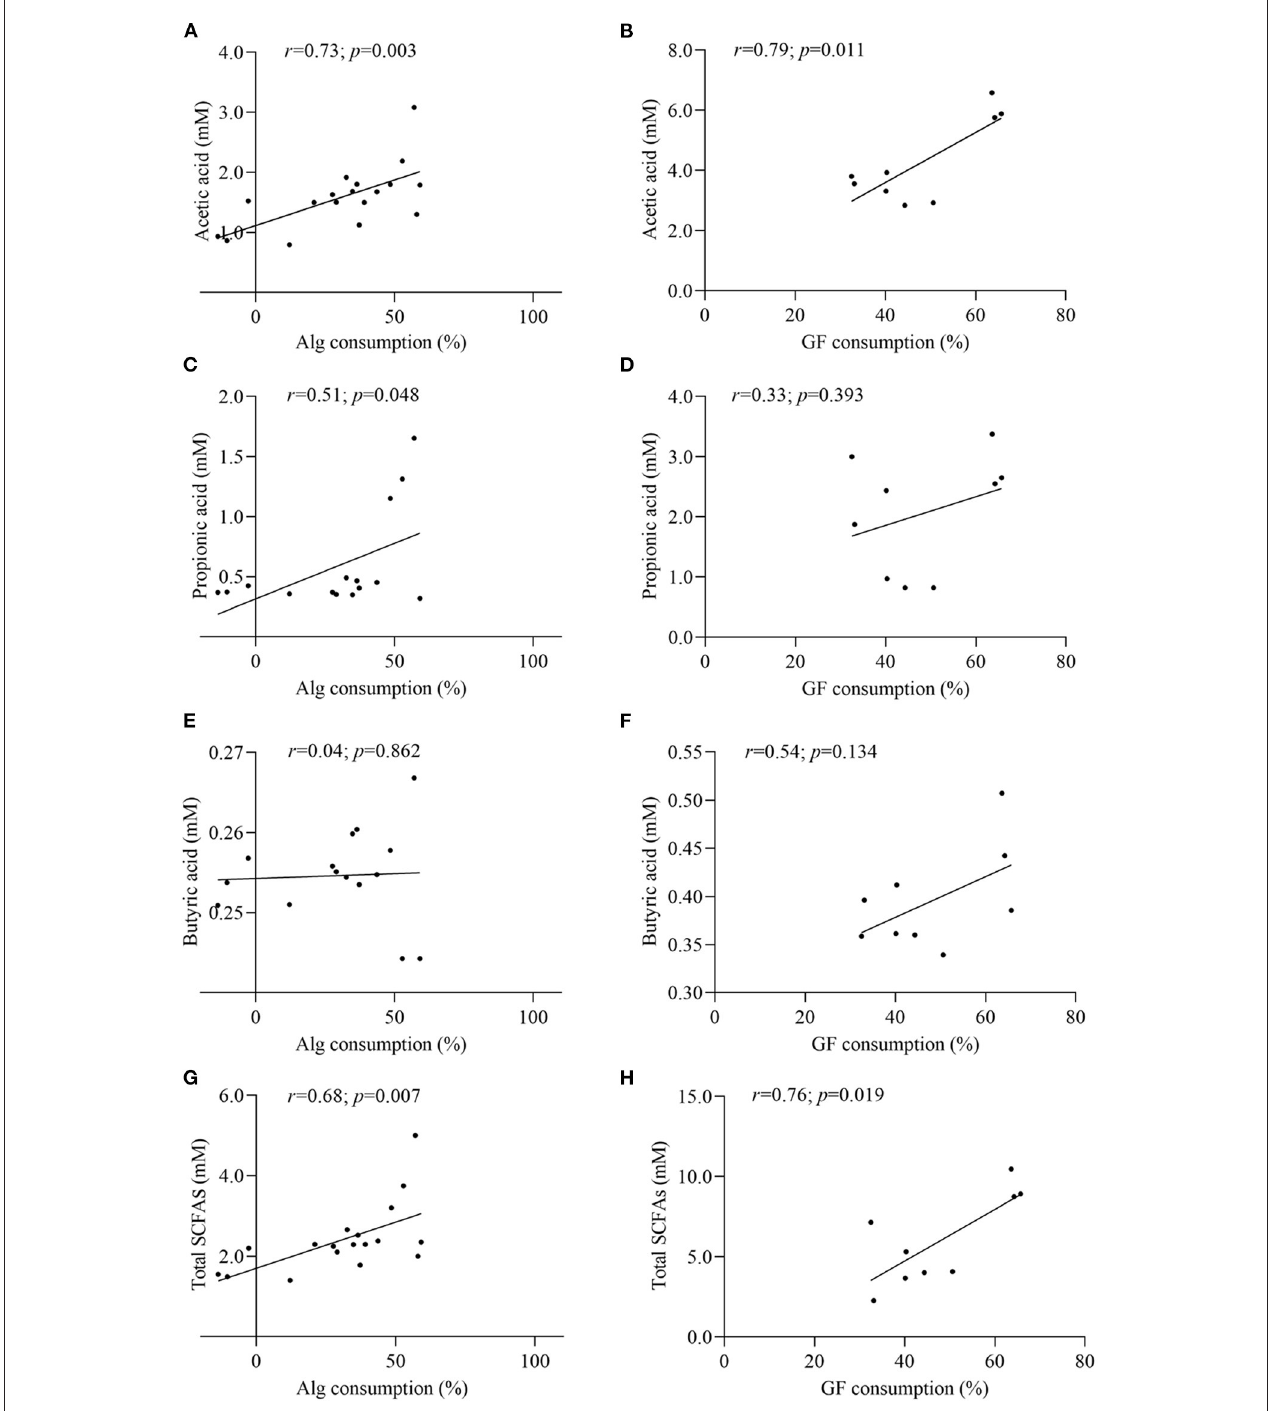
FIGURE 5 | Correlation analysis between Alg and GF consumption with the contents of acetic acid (A,B) , propionic acid (C,D) , butyric acid (E,F) , and total SCFAs (G,H) .